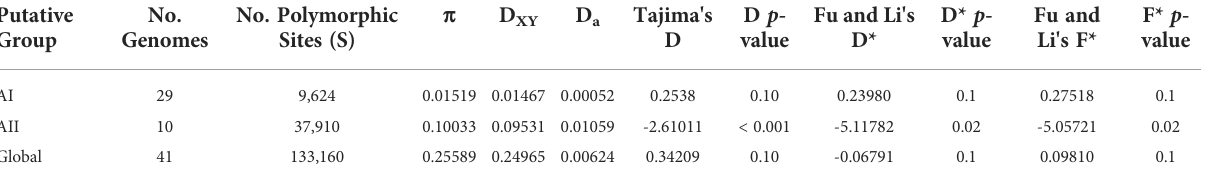
TABLE 1 Average Divergence and Estimates of Nucleotide Diversity within lineages (across silent sites only). Putative Group